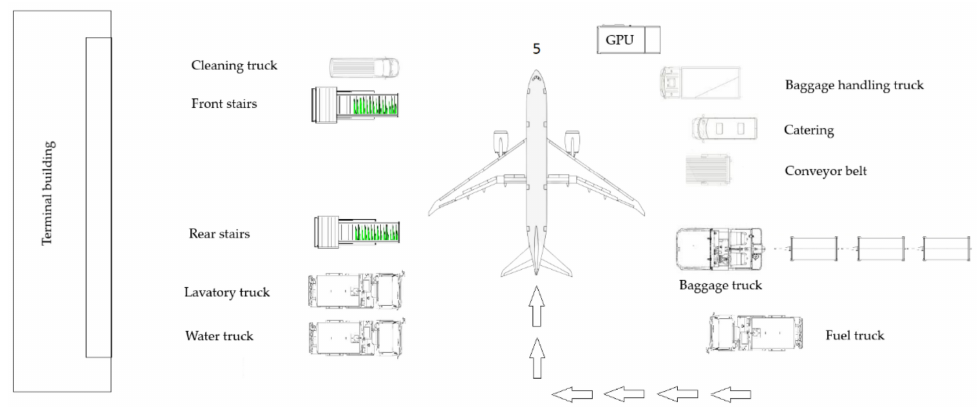
Figure 2. Deployment of ground handling equipment after changes were